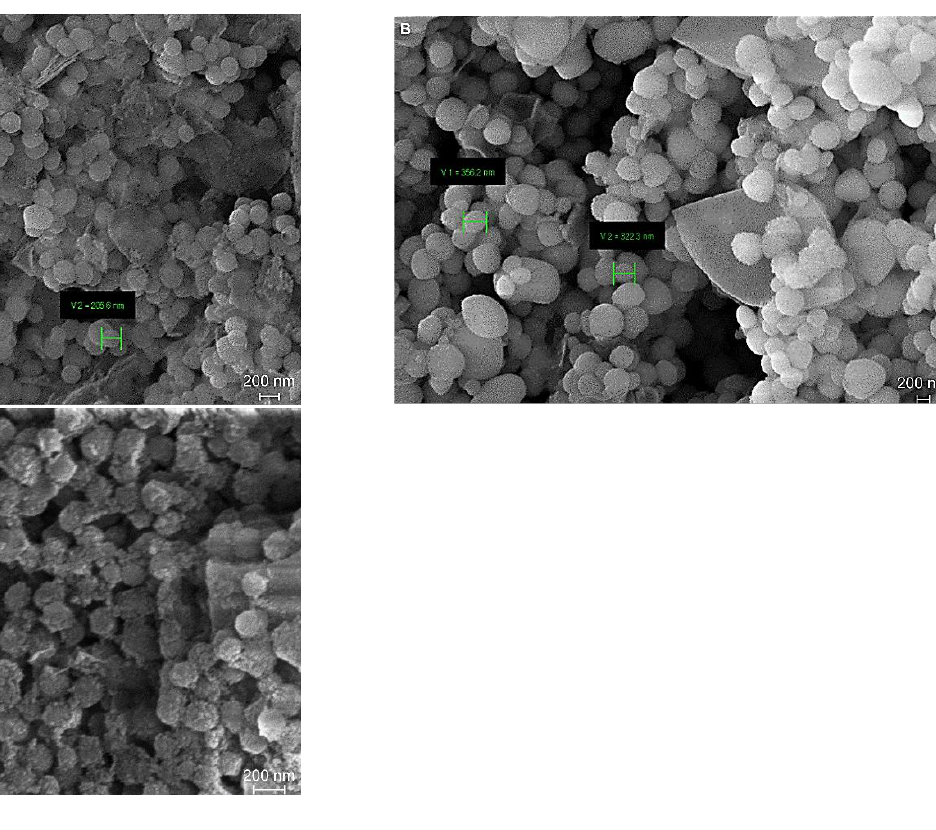
Figure 3. SEM analysis for SiO 2 ( A ), SiO 2 -BCD-OH ( B ), and SiO 2 -BCD-NH 2 ( C ). From the SEM images, the spherical shape of the SiO 2 particles was visible, but their dimension varied between the samples. In the case of SiO 2 -BCD-OH , the particle diameter was about 300 – 350 nm, while for SiO 2 -BCD-NH 2 and SiO 2 it was around 150 – 200 nm. The silica generation process included several steps involving the formation of the initial “clouds” fol lowed by densification, resulting in the primary particles that underwent col- lapse or association, leading to assemblies that undertook the growth process [53]. In our case, the particle size variation was attributed to the alteration of the particle growth pro- cess due to the presence of Si-BCD-OH derivatives (Scheme 2). This is plausible since the initial nucleation stage was independent of the presence of Si-BCD derivatives; therefore, the initial particles ’ number and primary particles should be similar in all cases. However, the insertion of Si-BCD changed the growth process, and, in the case of Si-BCD-OH , the growth of the assemblies was favored. In contrast, for Si-BCD-NH 2 , the process was much more similar to SiO 2 . In the case of Si-BCD-OH , there was the chance of di-silyl deriva- tives being formed as the result of similar reactivity between the -OH groups. In contrast, in the case of Si-BCD-NH 2 , due to the higher reactivity of -NH 2, the monosubstituted silyl formation was favored. Thus, the presence of di-silyl Si-BCD-OH may be the explanation for the alteration of the silica formation process by promoting the growth of the assem- blies.